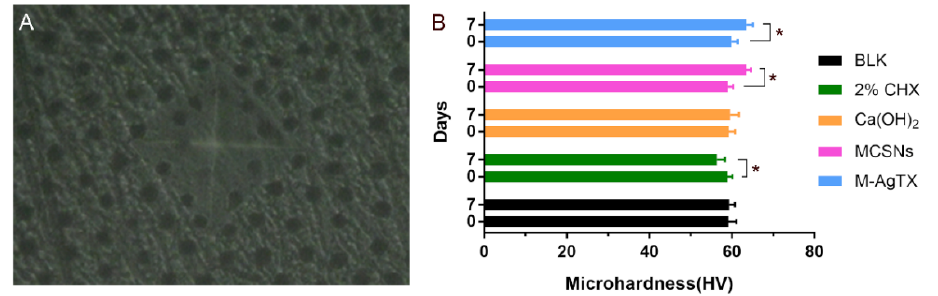
Figure 12. Dentin microhardness measurement. ( A ) Representative image of dentin slices in micro- hardness measurement (×40); ( B ) Comparison of microhardness among groups. (*: p < 0.05) .